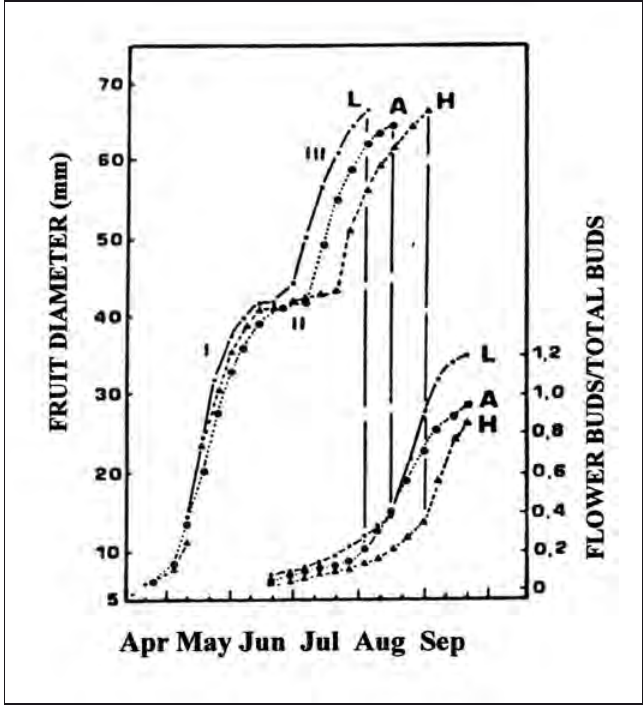
Fig. 18 - Fruit growth and percent of fruit bud formed on shoots of three cultivars of peach tree with different ripening times (Giulivo et al ., 1981 a).